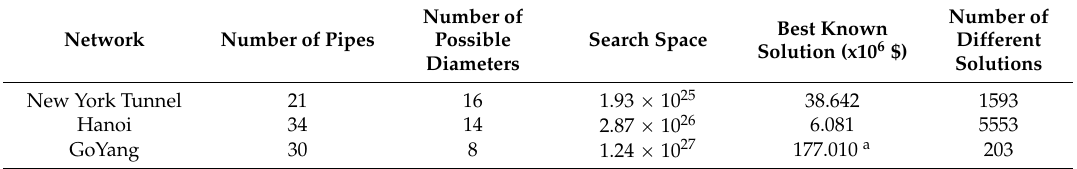
Table 1. Main characteristics of the benchmark problems used in the paper (adapted from [31]).